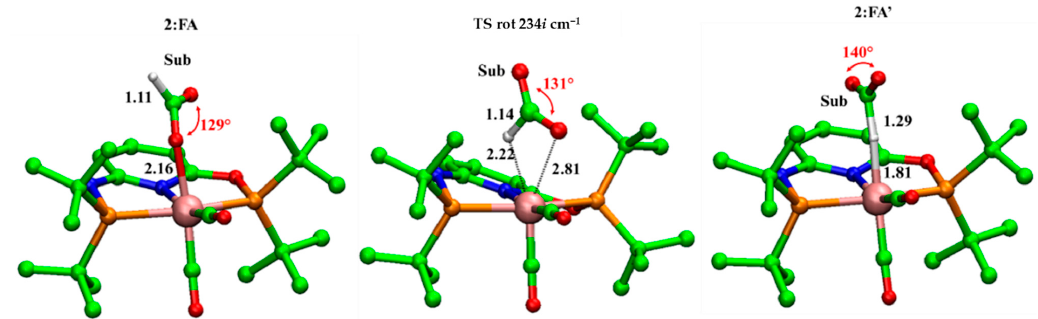
Figure 2. B3LYP-D3/6-31+G(d,p) optimized geometries of 2:FA, TS rot and 2:FA’ . Distances implicated in chemical event (black) are in Å. Imaginary frequencies are also reported. For clarity, hydrogens are not shown.